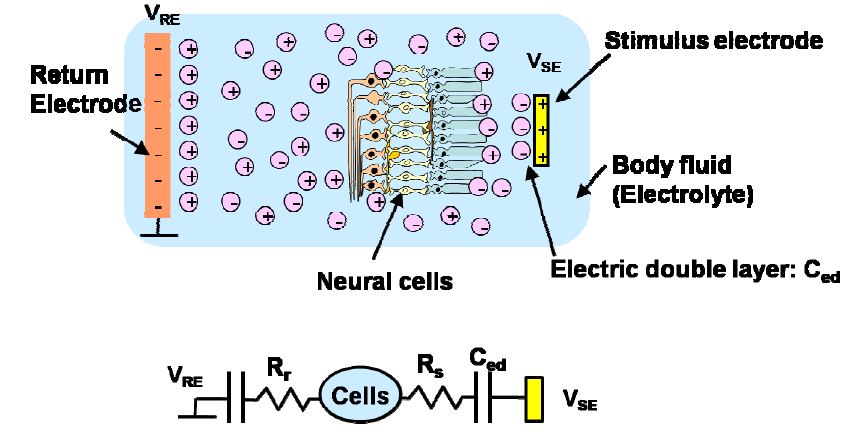
Figure 2. Electrical stimulation of neural cells in body fluid (a) and its equivalent circuits